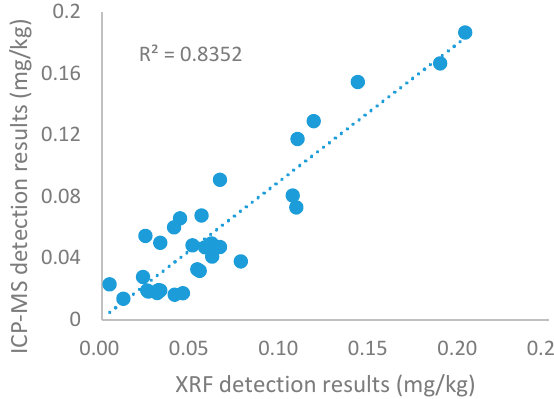
Figure 2. Relationship between XRF detection results and ICP-MS detection results.